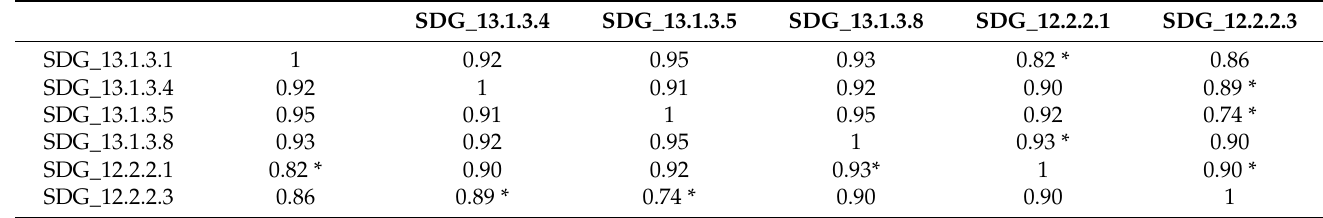
Table A6. Pairwise Pearson’s Correlation Between SDG 13 and SDG 12.